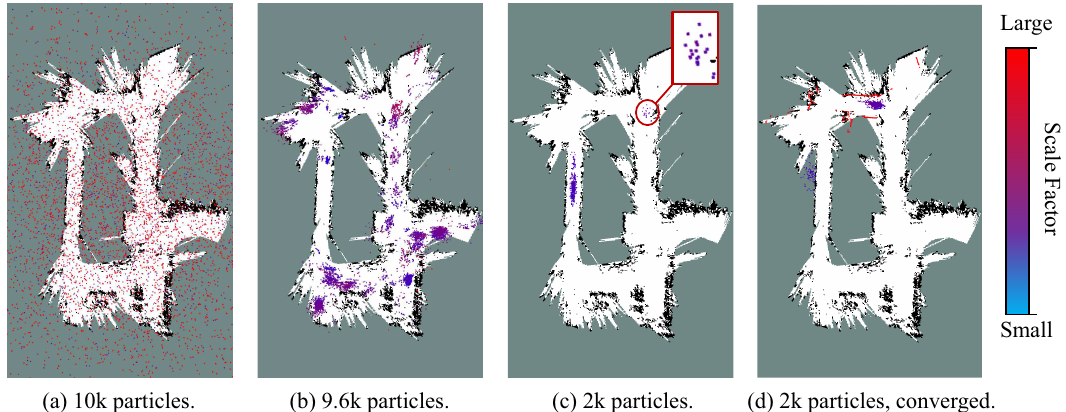
Figure 10. Particle distribution during the initial stage of the global localization process on the sequence ms-38 . The scale factor of the particles are indicated by their colors. ( a ) The initial distribution of the particle filter. ( b ) The particle filter yields a highly diverse range of particle clusters after a few seconds. ( c ) A small number of clusters survive after several updates. The correct robot state is represented by the cluster labelled with the red circle. ( d ) The particle cloud is converged, suggesting that the scale estimation has been